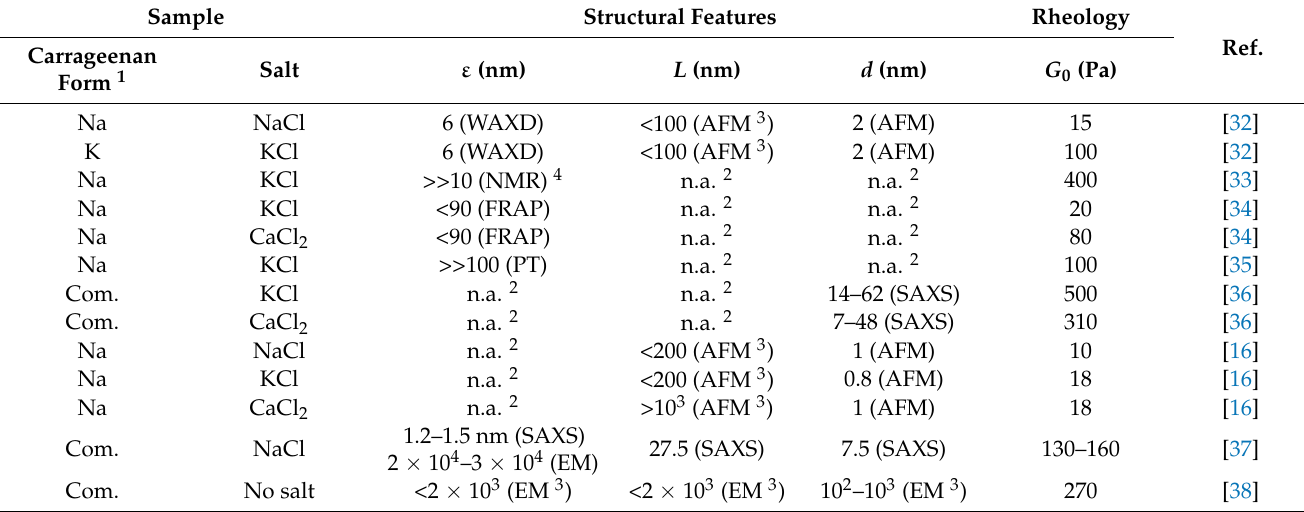
Table 2. Elastic and structural properties of Iota gels. Same column labelling and notes as in Table 1.